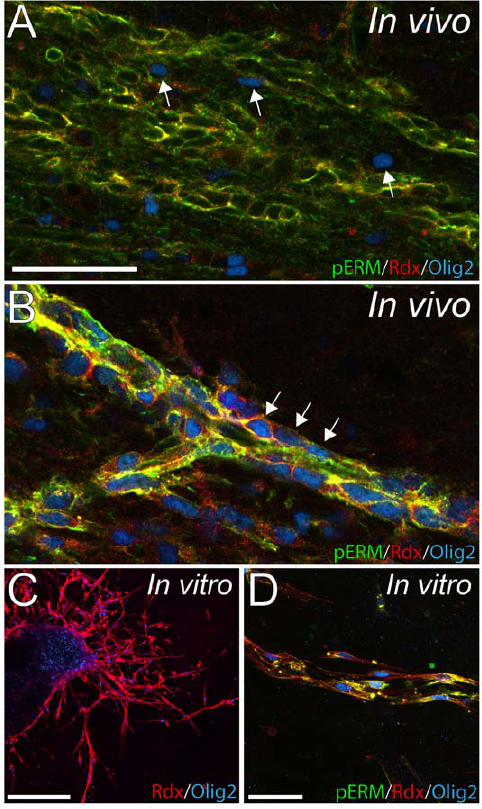
Figure 11. Alignment of Olig2 + cells in chains invivo and invitro explants. ( A ) Olig2 + cells in the control rostral migratory stream are few and separated (arrows). ( B ) Radixin (Rdx) and Olig2 co-expressing cells in the EGF-treated RMS express phosphorylated (ezrin, radixin, and moesin) (pERM) and are associated in chains (arrows). ( C ) Extensive radixin (red) and Olig2 (blue) immunoreactivity of migratory cells in explant cultures. ( D ) Tightly associated radixin + /Olig2 + cells in explant cultures resemble the appearance of in vivo migratory chains and also express pERM. Scale bar in A=50 m m, C=200 m m and D=50 m m.